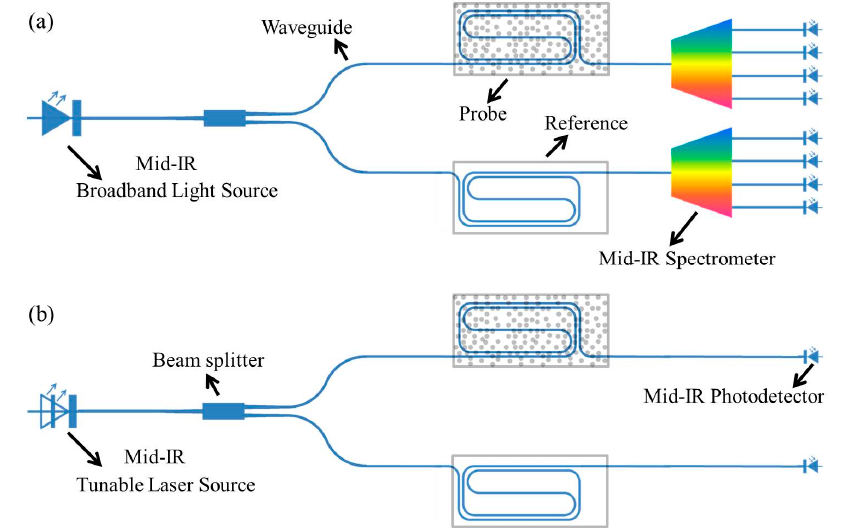
Figure 1. ( a ) Schematic of two silicon photonic configurations to realize an integrated on-chip mid- infrared absorption spectroscopy sensor. Broadband source and spectrometer, best suited for liquid and solid analytes; ( b ) Tunable single mode laser source for trace gas